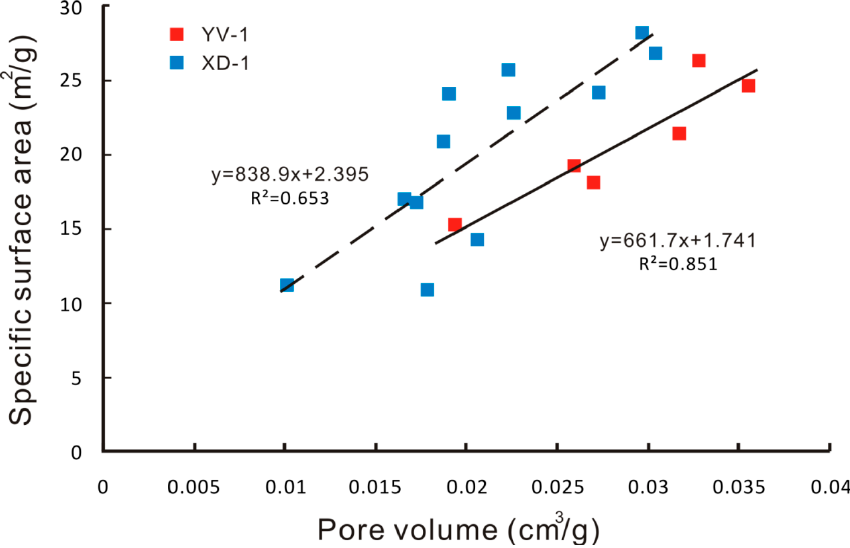
Figure 11. Relationships between pore volume and specific surface area of YV-1 and XD-1. The distribution of pore volume with pore size can be used to represent pore size distribution, including cumulative, incremental, differential pore volume distribution curves [9]. In this study, we used incremental pore volume distribution curves to investigate the characteristic of the PSD. The peak in the PSD curve represents the development of the corresponding pore size.